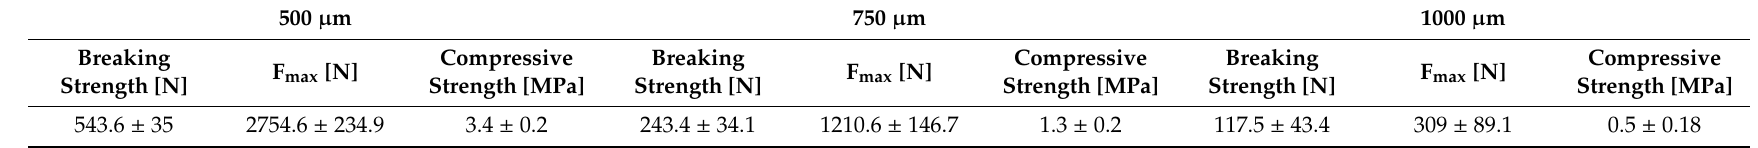
Table 4. Breaking and compressive strength of the di ff erent sized samples (N = 10) .